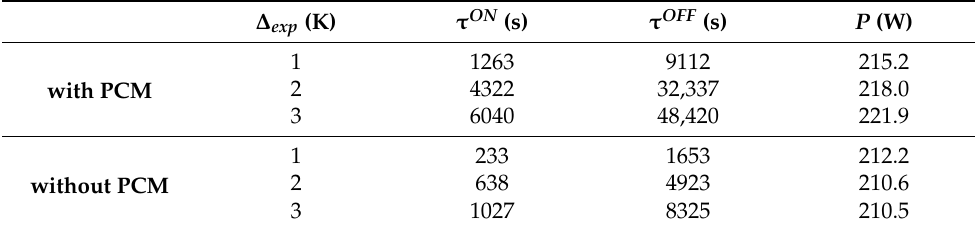
Table 1. Experimental data used as inputs for the optimization model [43]. ∆ ON (s) τ OFF (s) P (W) exp (K) τ with PCM